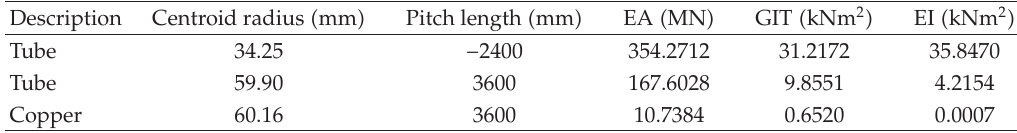
Table 10: Umbilical 7